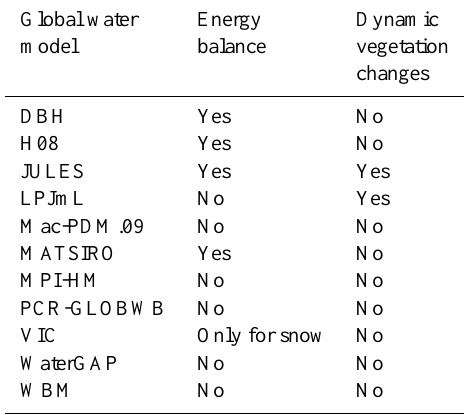
Table 2. Short characterisation of the applied water models. More details are provided in Sect. 3.5 in the